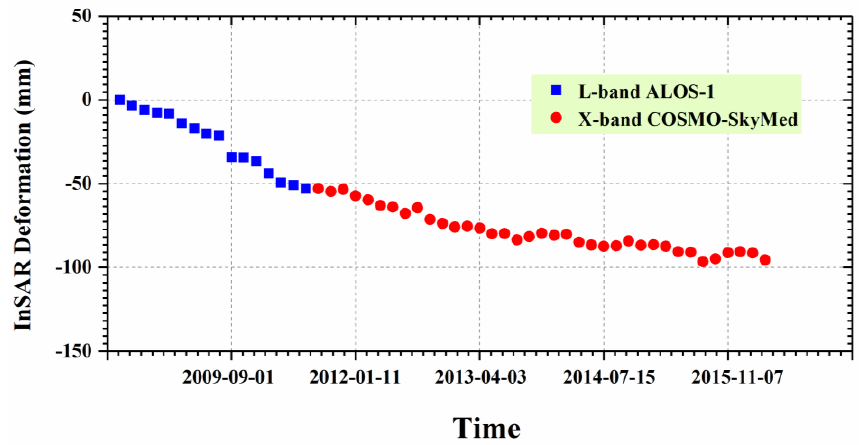
Figure 15. Time series deformation at point P2 marked in Figure 13 and Figure 14.